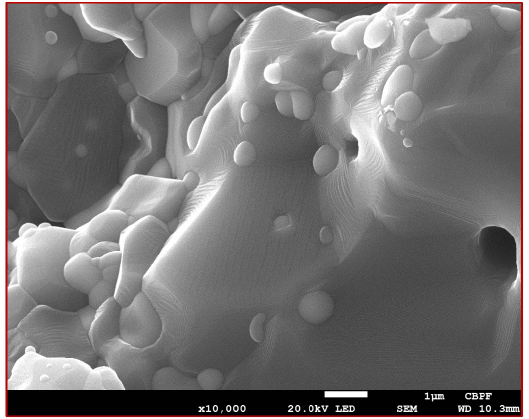
Figure 10. SEM Micrograph of the fracture surface of the sample of group B with larger grains belonging to the alumina matrix and smaller grains of